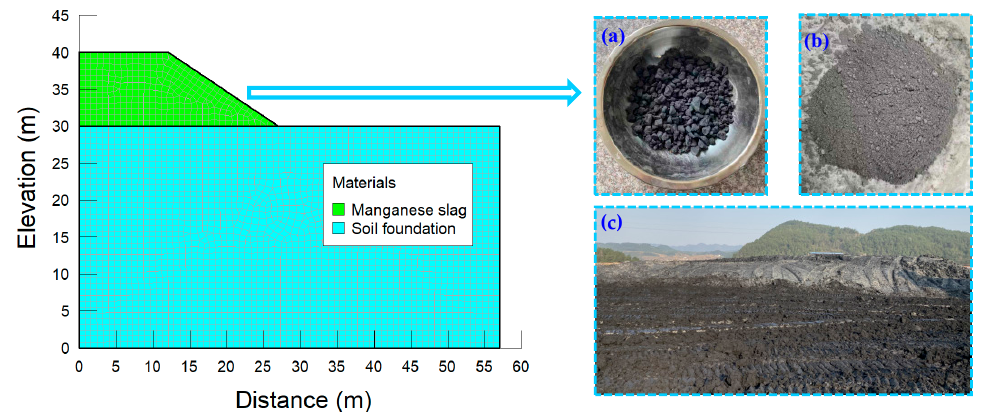
Figure 9. Finite element model and field material.